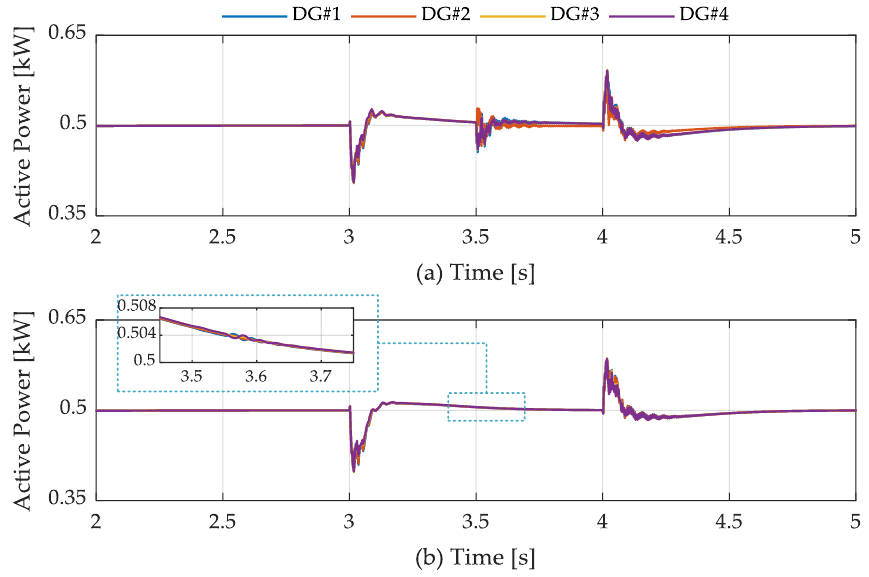
Figure 14. Output active power of each DG: ( a ) centralized method; ( b ) proposed method.